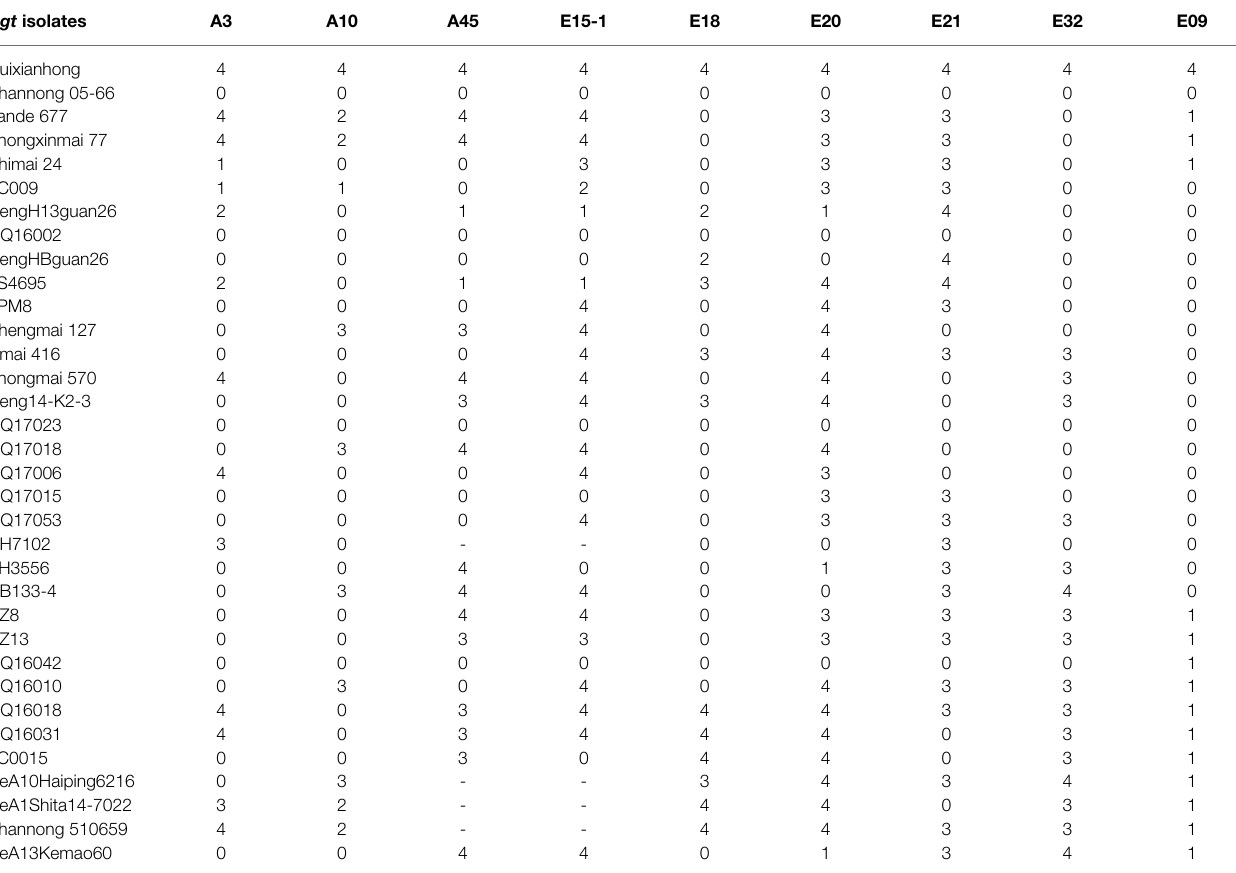
TABLE 3 | Reaction patterns of the wheat genotypes with Pm2 alleles to nine Blumeria graminis f. sp . tritici ( Bgt ) isolates. Bgt isolates